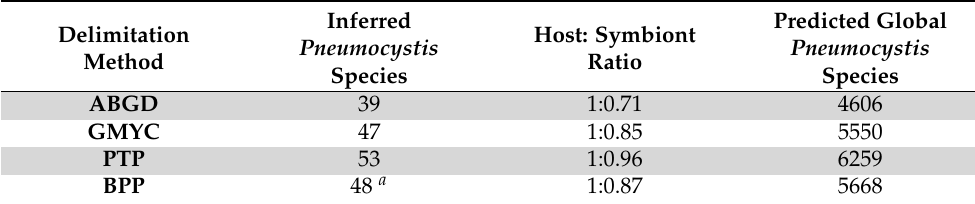
Table 1. Inferred species delimitations and host:symbiont ratios a Although ten Pneumocystis samples were not included in the BPP analysis, we include them in the result here due to the confidence that they cannot be grouped into any other species. This makes the result comparable to the other three methods. Predicted Global Inferred Host: Symbiont Delimitation Pneumocystis Pneumocystis Ratio Method Species Species ABGD 39 1:0.71 4606 GMYC 47 1:0.85 5550 PTP 53 1:0.96 6259 BPP 48 a 1:0.87